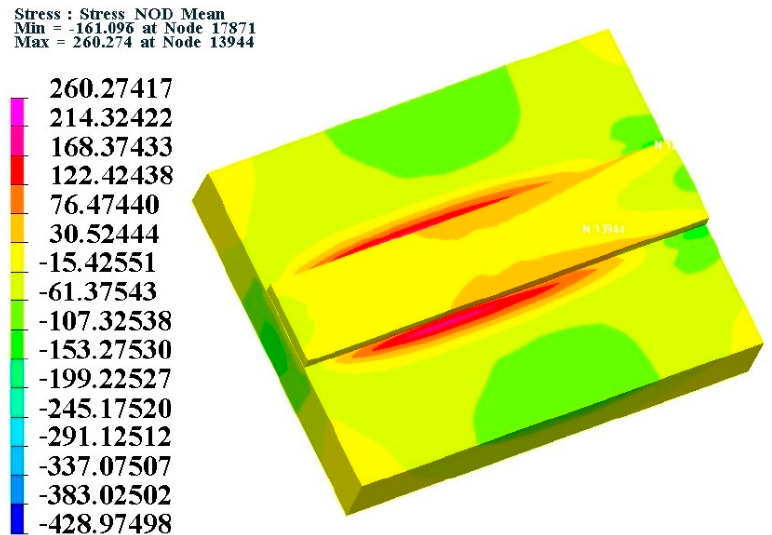
Figure 13. Residual stress cloud diagram after surfacing welding.